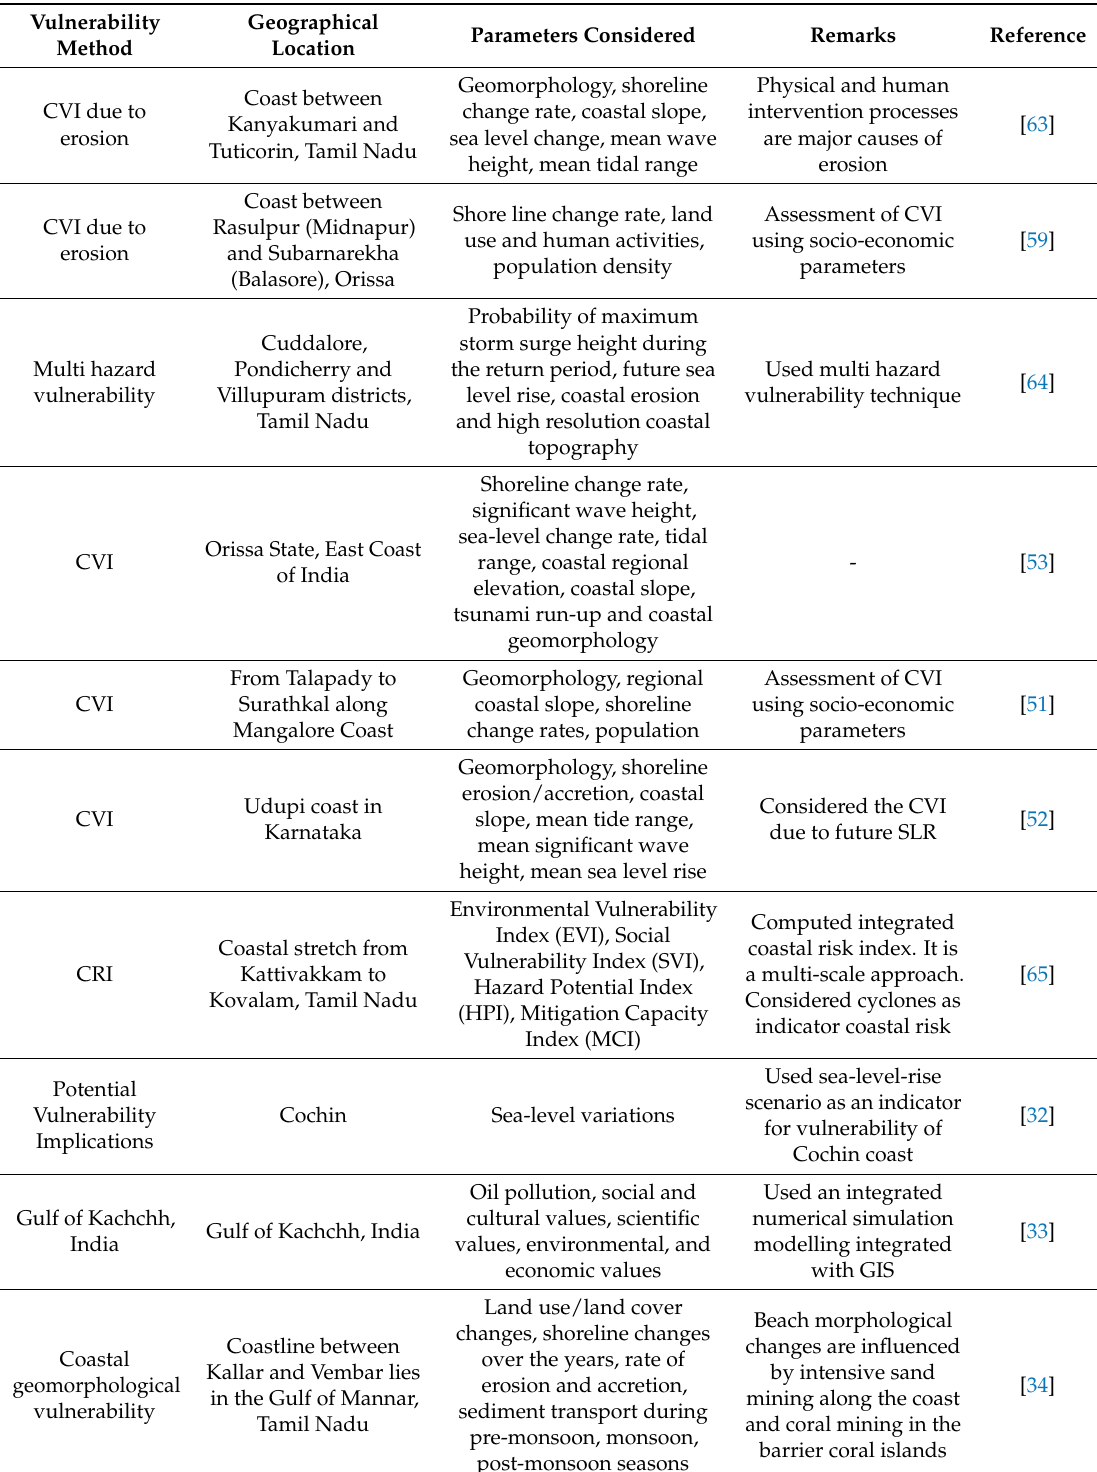
Table 1. Vulnerability assessment and parameters considered for different Indian geographic locations (modified from Rani et al. 2015).